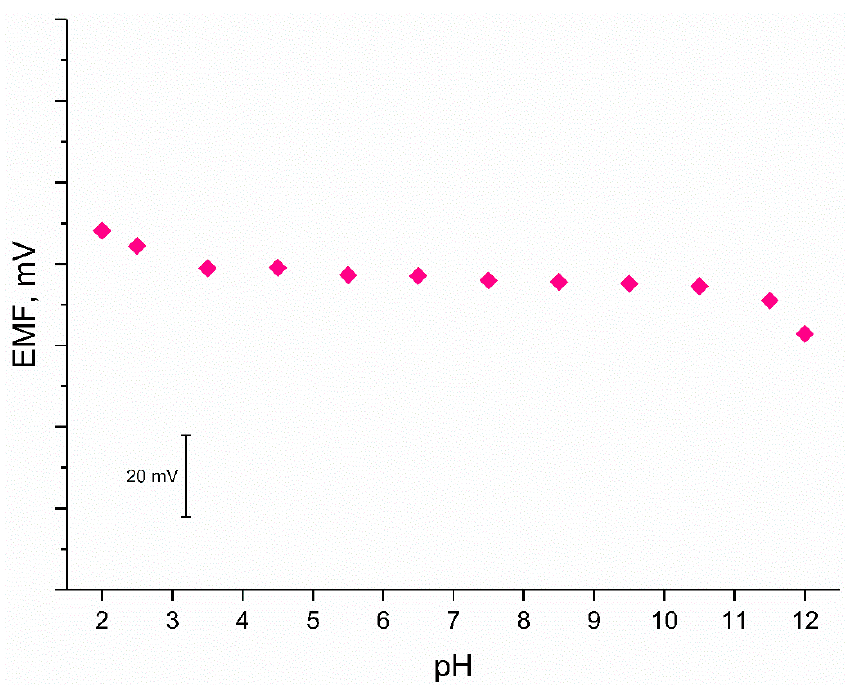
Figure 8. Potentiometric response of studied GC/RuO 2 + PEDOT:PSS/K + -ISM electrode (one electrode representing the group of solid-contact electrodes) showing its insensitivity to a changing pH value.